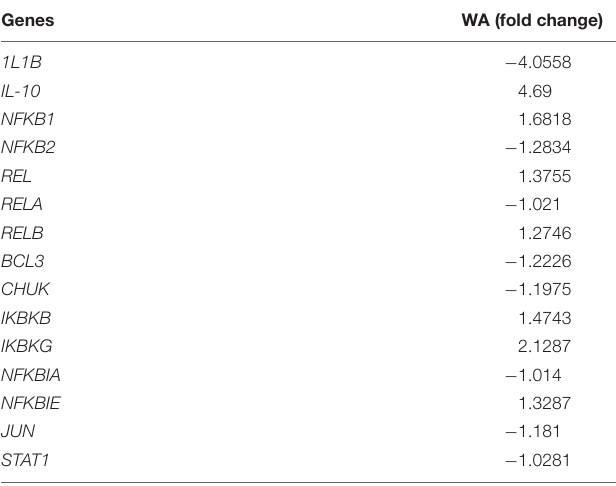
TABLE 1 | Withaferin A (WA) inhibits nuclear factor-kappa B (NF- κ B)-mediated inflammatory genes expression.